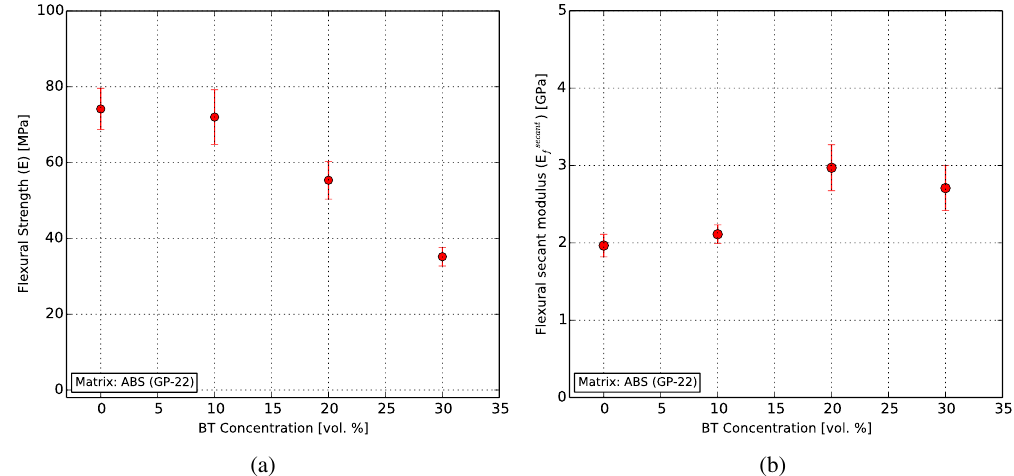
Figure 12. Flexural behavior of the composites, with ( a ) increasing filler content decreasing the flexural strength of the composite and ( b ) increasing the flexural secant modulus of